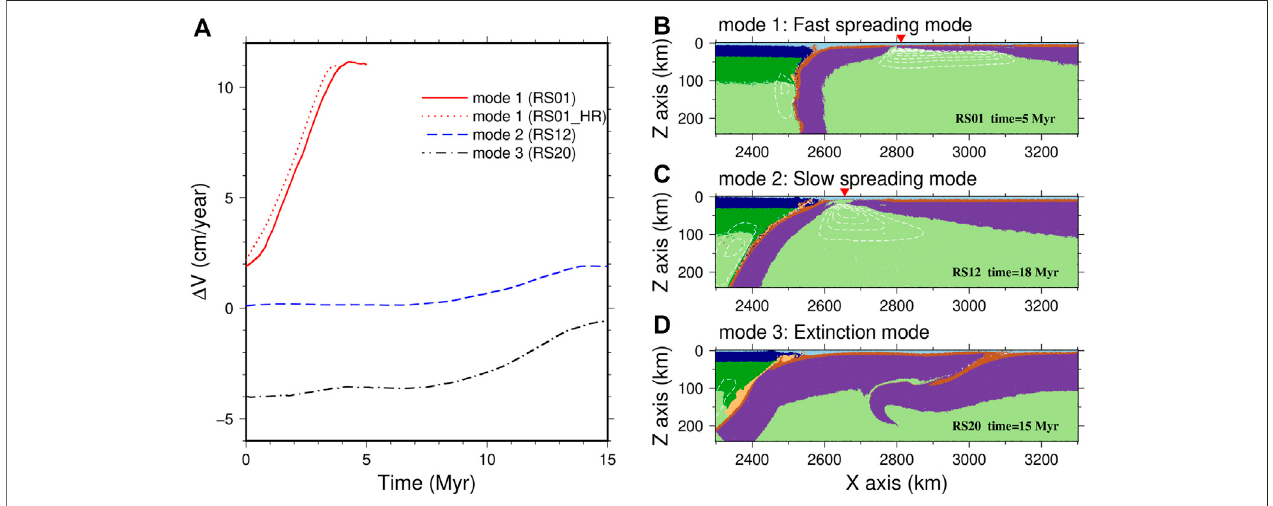
FIGURE2|(A) Timeevolutionof Δ v forcases RS01,RS12andRS20withdifferentMOR subductionmodes. (B – D) showthezoomed-in areaoftheMORforcase RS01at5 Myrs,caseRS12at18 MyrsandcaseRS20at15 Myrs.Thewhitedashedlinesrepresenttheextentofmeltingwithanintervalof5%.Theredinvertedtriangle represents the location of the